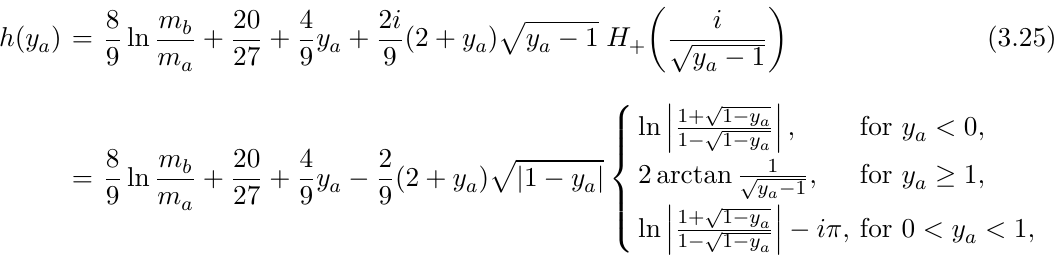
occurring in the four-quark operator matrix elements in eq. (3.23).